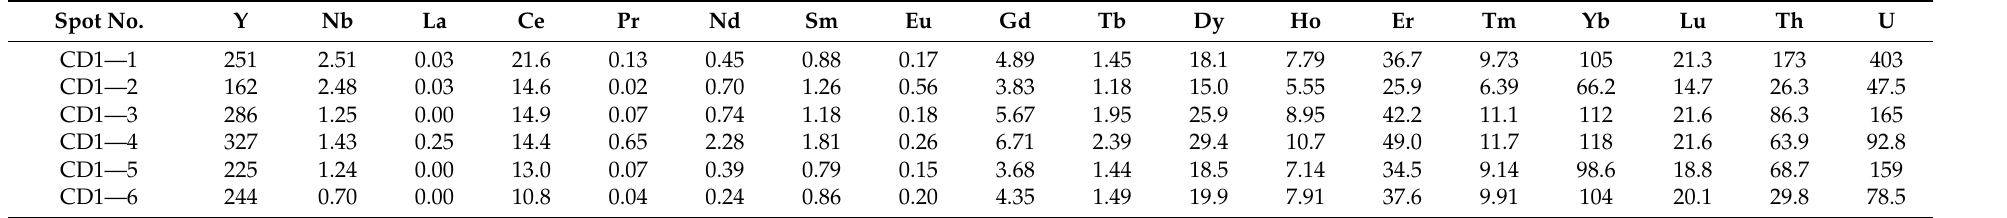
Table 2. LA-ICP-MS zircon trace element results (ppm) for the Gaositai hornblendite. Spot